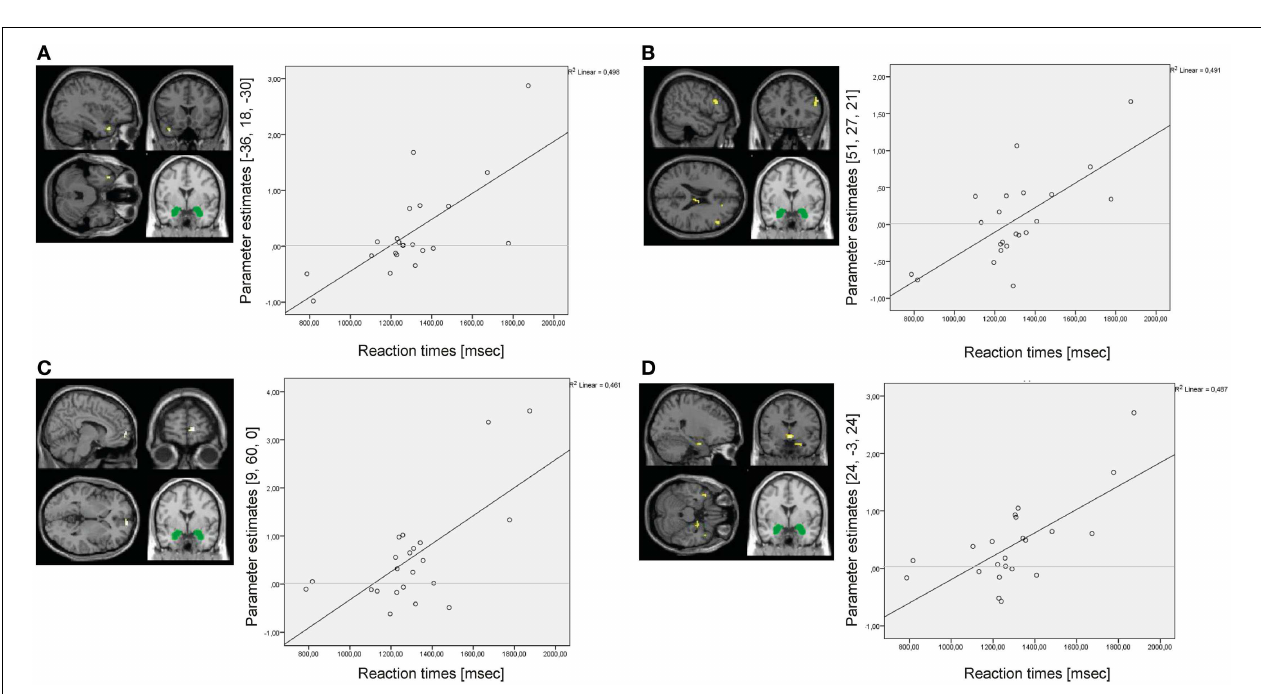
(MNI: − 36, 18, − 30). (B) Regression for amygdala connectivity with right middle frontal gyrus (MNI: 51, 27, 21). (C) Regression for amygdala connectivity with right medial frontal gyrus (MNI: 9, 60, 0). (D) Regression for amygdala connectivity with right parahippocampal gyrus/hippocampus (MNI: 24, − 3,